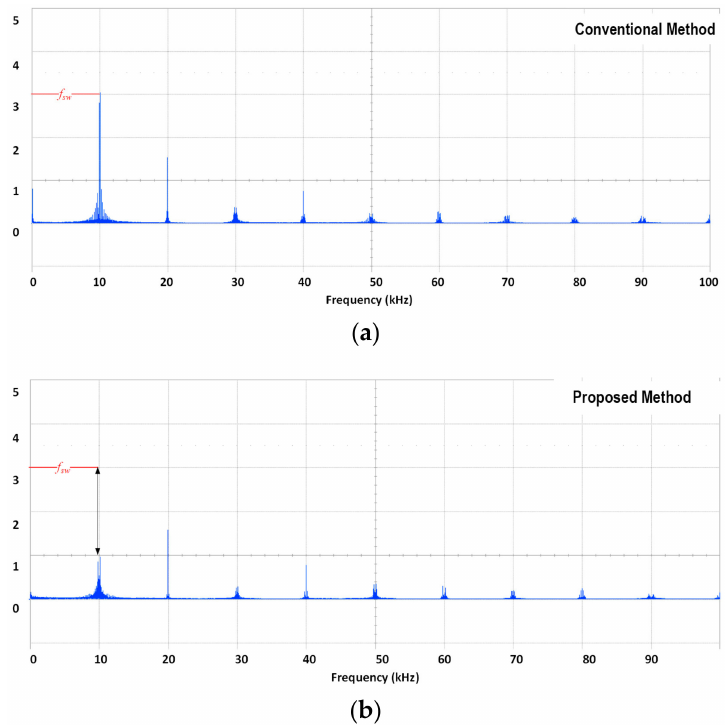
Figure 14. Experimental results for the DC-link ripple current FFT: ( a ) The conventional method and ( b ) the proposed